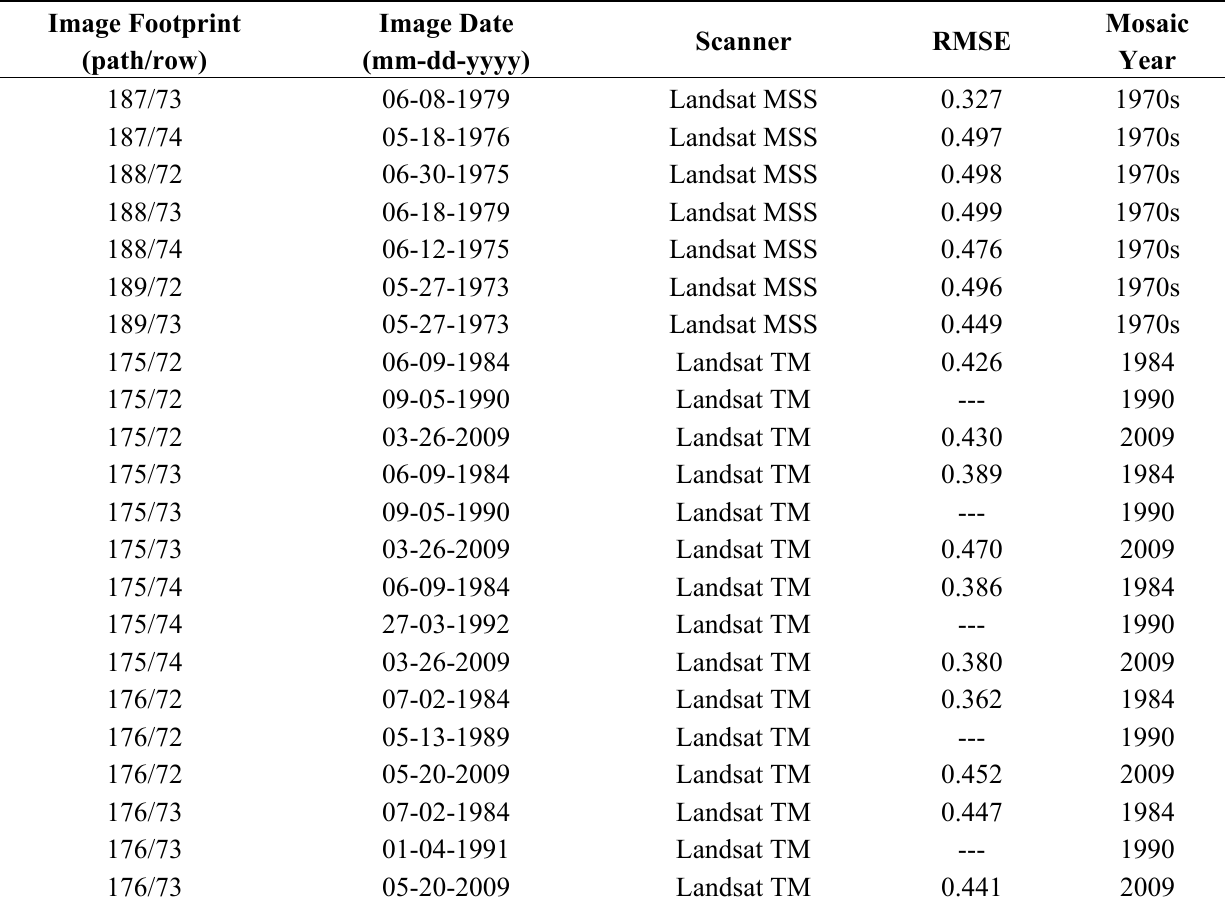
Table 2. Image characteristics of image location, date, scanner system and level of registration error for each of the image products utilized in this analysis. Root-mean-square errors (RMSEs) for the 1990 images are not included, as these images served as the reference image for images. MSS, Scanner; TM, Thematic